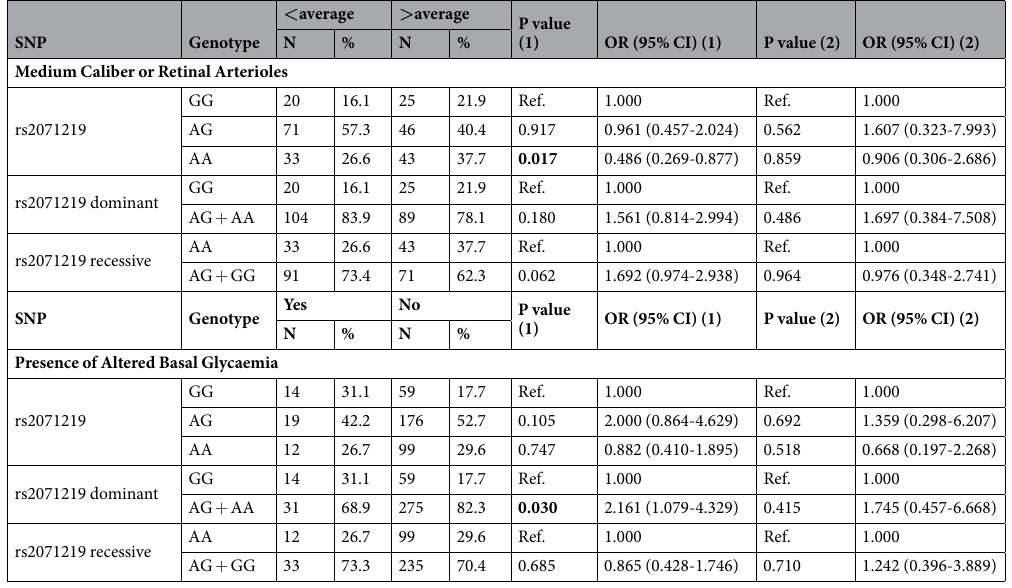
Table 4. Distribution of ALK1 rs2071219 genotypes according to the medium caliber of retinal arterioles and to the presence of altered basal glycaemia. P value & OR adjusted by sex and age (1) and by sex, age, DM, HTA, DL, tobacco, alcohol and BMI (2). CI = confidence interval; OR = odd ratio; ref. = reference; SNP = single nucleotide polymorphism. Statistically significant results in bold.